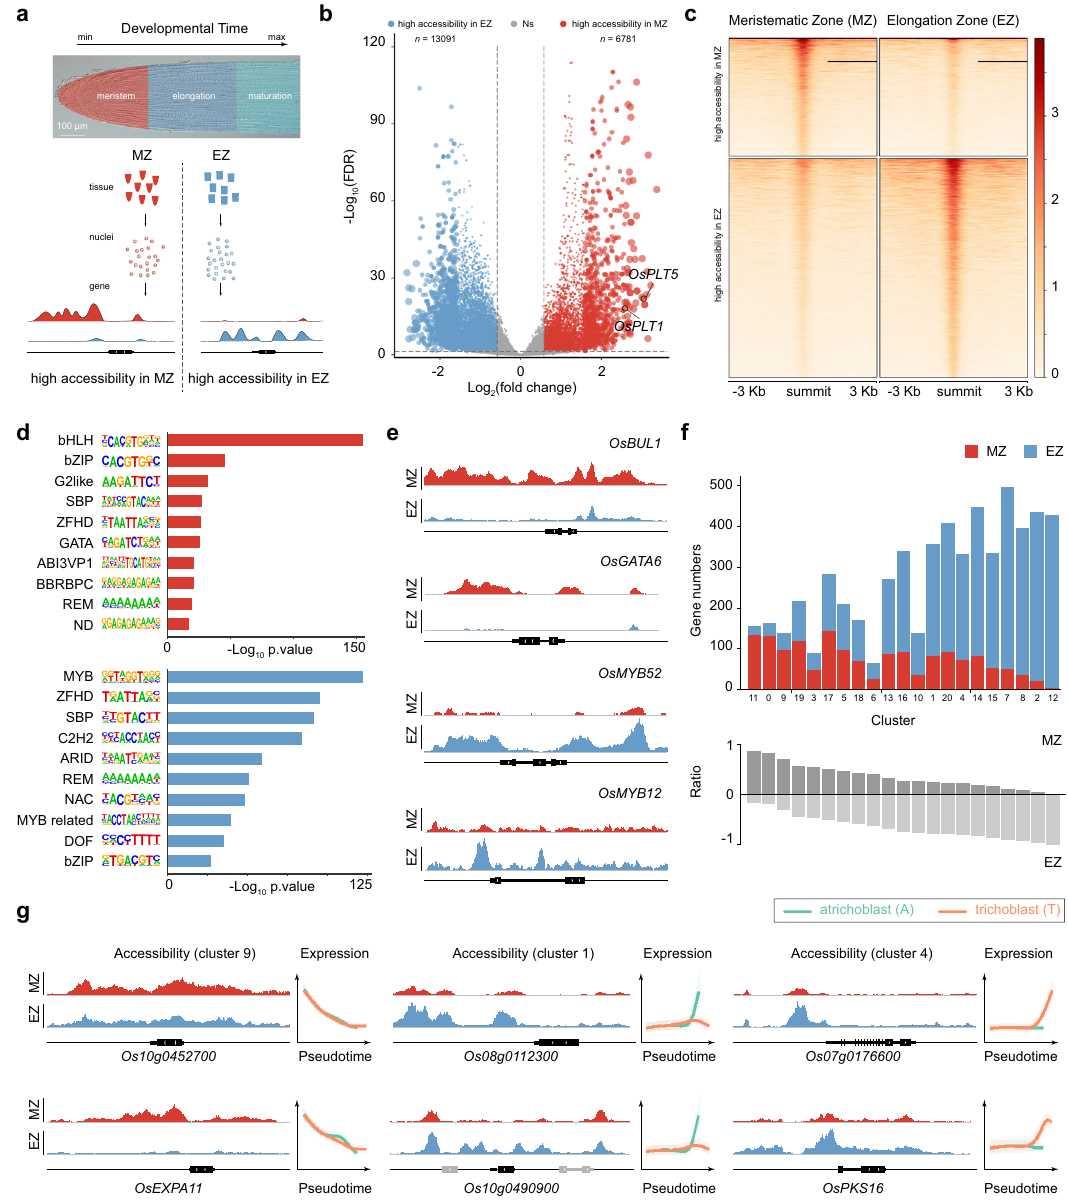
Fig. 4 Inference of transcriptional regulatory basis by ATAC-seq and scRNA-seq. a Schematic of tissue sampling. MZ, meristematic zone; EZ, elongation zone. b Volcano plot showing differentially accessible peaks between the MZ and EZ samples. Blue and red, highly accessible peaks in the EZ and MZ samples, respectively; Gray, no difference between the MZ and EZ samples. The number of differential peaks in each sample is given. FDR < 0.05; log 2 (fold change) > 0.58 or < − 0.58. c Pileup of ATAC-seq signals. Heat maps are ranked in decreasing order of ATAC-seq signal. Window size: peak summit ±3.0 kb. d Enrichment of transcription factor binding motifs within differential peaks in the MZ (red, top) and EZ (blue, bottom) samples. − Log 10 ( p value) for each binding motif is given. e Representative ATAC-seq tracks for bHLH ( OsBUL1 ), GATA ( OsGATA6 ) and MYB ( OsMYB12 and OsMYB52 ) transcription factor family genes. The genomic loci are shown, and the representative genes are highlighted in black. f Integrative analysis of scRNA-seq and ATAC-seq data. The genes associated with differential peaks identi fi ed in c were assigned to 21 cell clusters. The number of genes showing high accessibility in the MZ or EZ in each cell cluster is shown in different colors (top). The ratio (bottom) was calculated by the number of genes showing high accessibility in the MZ or EZ sample/total number of cluster-speci fi c genes. g Representative ATAC-seq tracks for clusters 1, 4, 9 enriched genes. The genomic loci are shown, and the representative genes are highlighted in black. Two representative genes for each cluster are shown. Gene expression patterns during differentiation toward trichoblast (T) and atrichoblast (A) along the pseudotime are shown (right). Color annotation is the same in Fig. 2e. also identi fi ed (Fig. 1a). Due to limitations imposed by sequen- (Supplementary Fig. S10). For example, we found that the tran- cing depth and gene coverage, lowly expressed genes, which could scripts of Os04g0125700 are highly abundant in the root exo- include important transcription factors for cell fate determina- dermis (Supplementary Fig. S10), whereas Os01g0248900 and tion, maybe not faithfully recovered in our scRNA-seq datasets. Os10g0578200 are exclusively expressed in atrichoblasts and tri- Nevertheless, the cell-type-speci fi c reporters identi fi ed in this choblasts, respectively (Fig. 2h, i). Cell clusters corresponding to work can be used with cell-sorting methods to generate high the cortex, exodermis and sclerenchyma layers (cluster 6) were NATURE COMMUNICATIONS| (2021) 12:2053